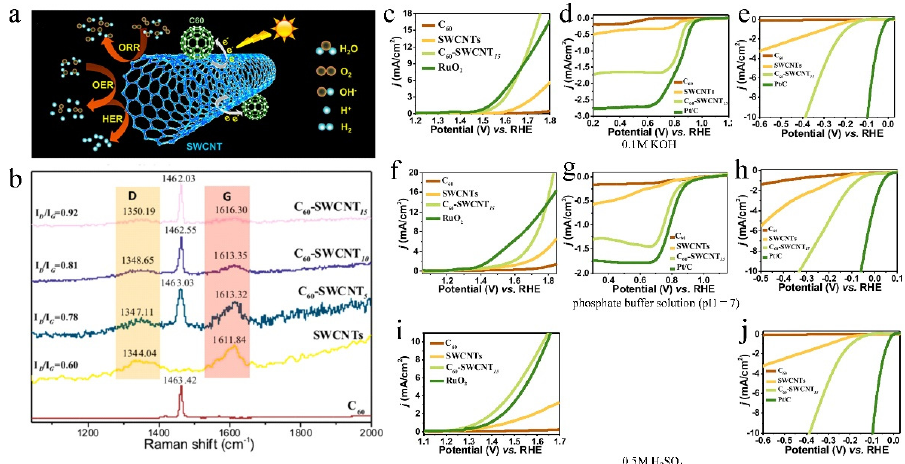
Figure 6. ( a ) Illustration of charge-transfer process and ORR/OER/HER on C 60 -SWCNTs. ( b ) Raman spectra of C 60 and C 60 -SWCNT n ( n = 0, 5, 10, and 15 min). LSVs of ( c ) OER, ( d ) ORR, and ( e ) HER for pure C 60 , SWCNTs, C 6- SWCNT 15 , and RuO 2 in 0.1 M KOH. LSVs of ( f ) OER, ( g ) ORR, and ( h ) HER for pure C 60 , SWCNTs, C 60 -SWCNT 15 , and RuO 2 in phosphate-buffered solution. LSVs of ( i ) OER, and ( j ) HER for pure C 60 , SWCNTs, C 60 -SWCNT 15 , and RuO 2 in 0.5 M H 2 SO 4 . Reproduced with permission [73]. Copyright 2019, American Chemical Society.